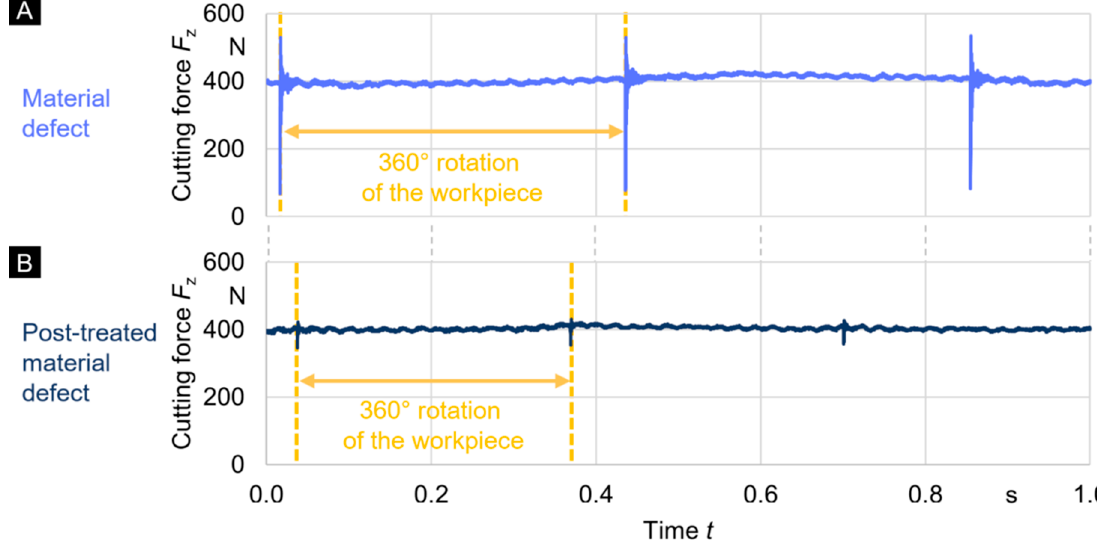
Figure 9. Cutting force components in z-direction during the machining of a post-cured material defect.